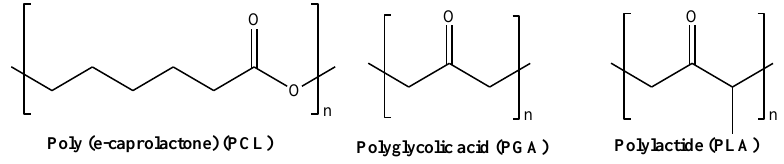
Figure 4. Molecular structures of some synthetic polymers.